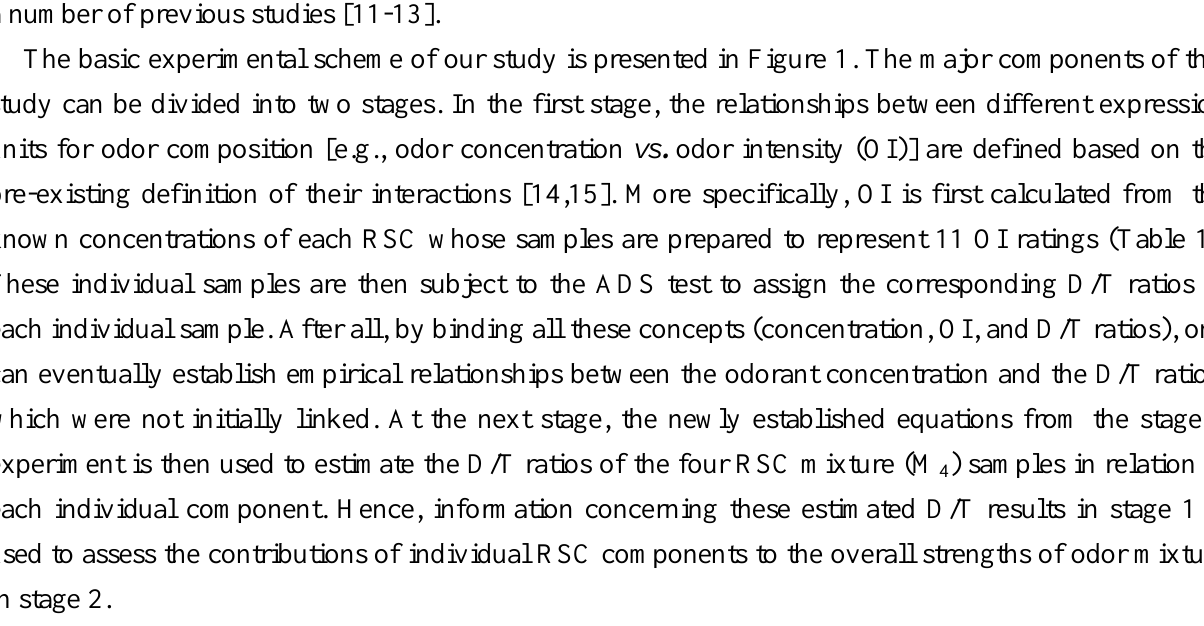
Figure 1. Schematic of the two-stage approaches for the comparison of D/T ratios between measured and predicted